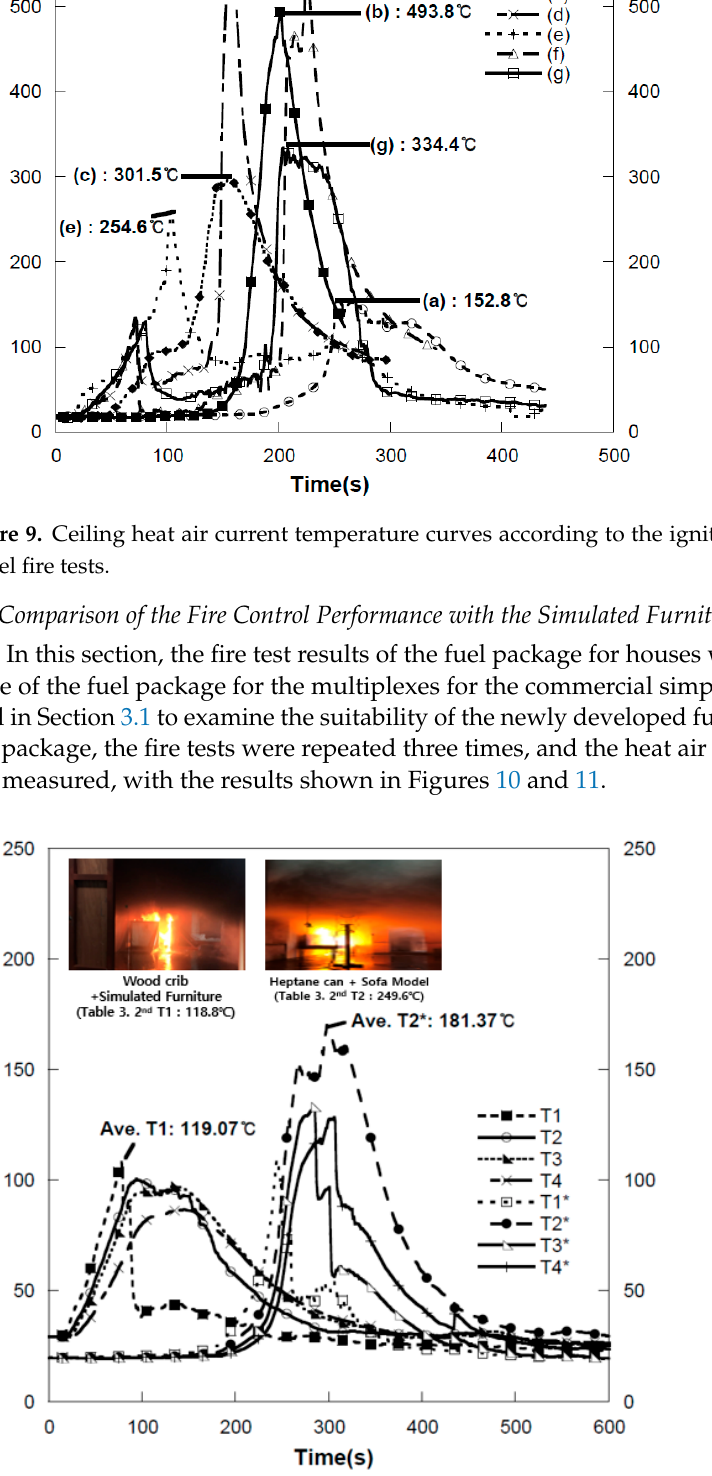
Figure 10. Comparison of the average heat air current temperatures around the ceiling in the fire tests of the fuel packages for residential spaces and multiplexes (*: fuel package for multiplexes).